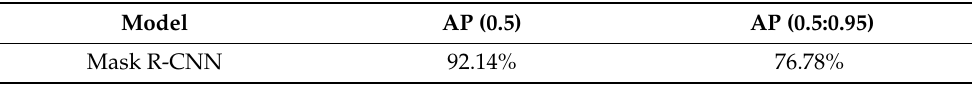
Table 1. Performance of tooth instance segmentation model.